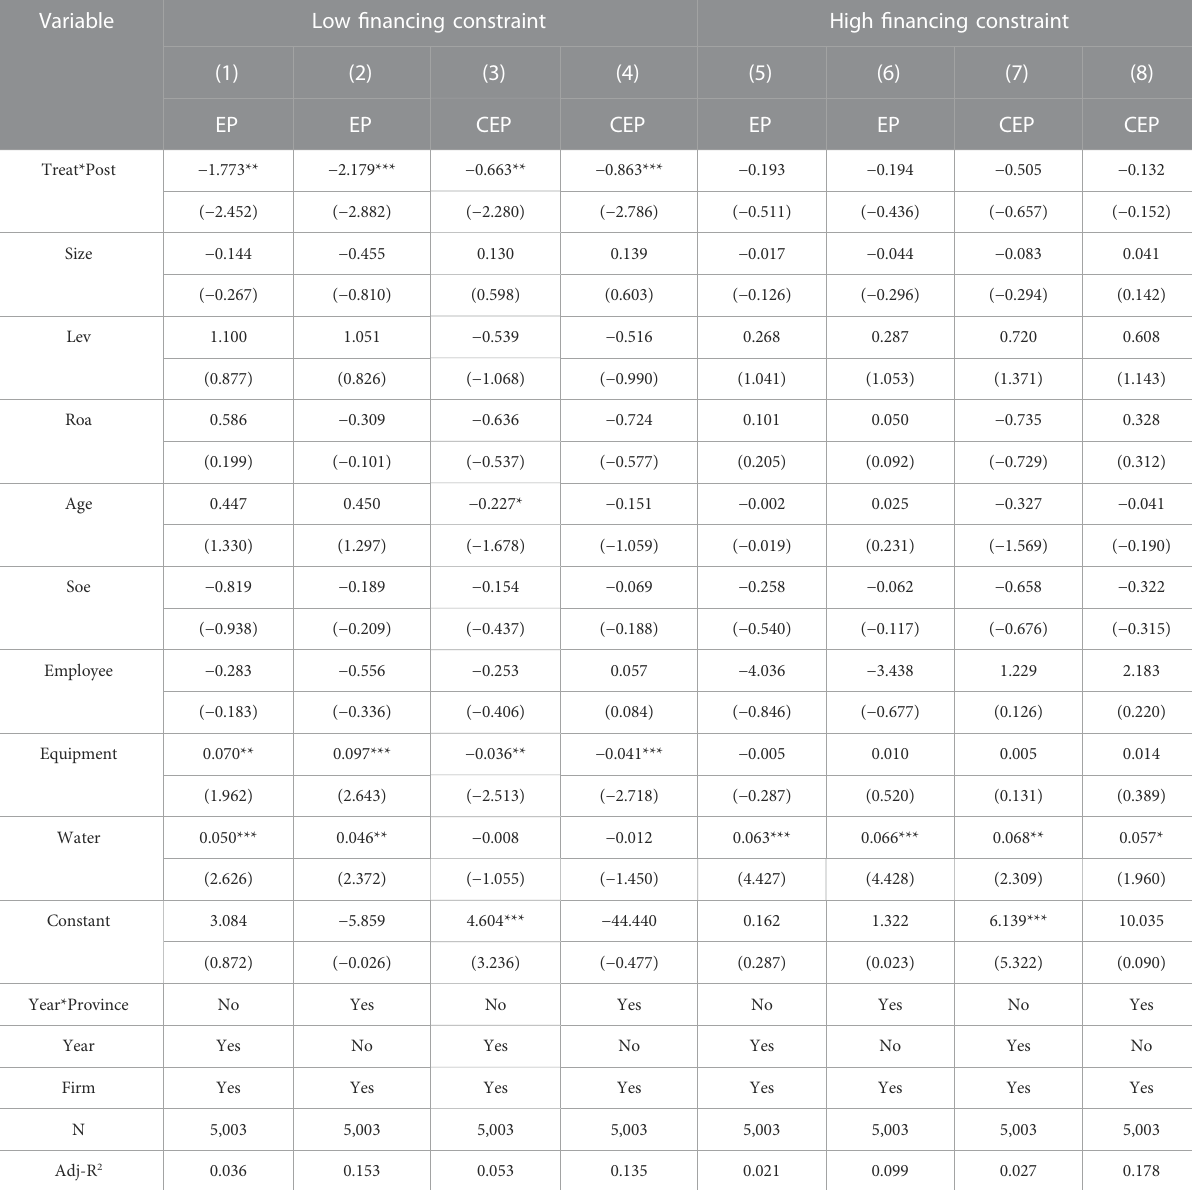
TABLE 4 NSMF program, fi nancing constraints, and corporate environmental